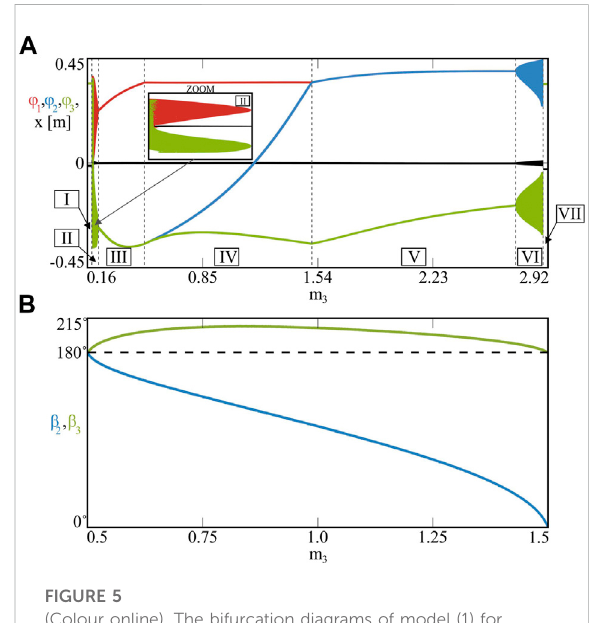
FIGURE 5 (Colour online). The bifurcation diagrams of model (1) for fi xed m m m ∈ [0.16,2.92][kg] (A) .The 1 =1.0, 2 =0.5[kg]andvaried 3 intervalissplitintosevencases(I – VII),dependingonthebehaviour of the pendula and possible solutions of system (8). The bifurcations of phases β 2 and β 3 corresponding to the phase – locked synchronous con fi gurations during stage IV are shown in panel (B) . Using bifurcation analysis, one can trace transitions occurring in the system and the arise of different types of